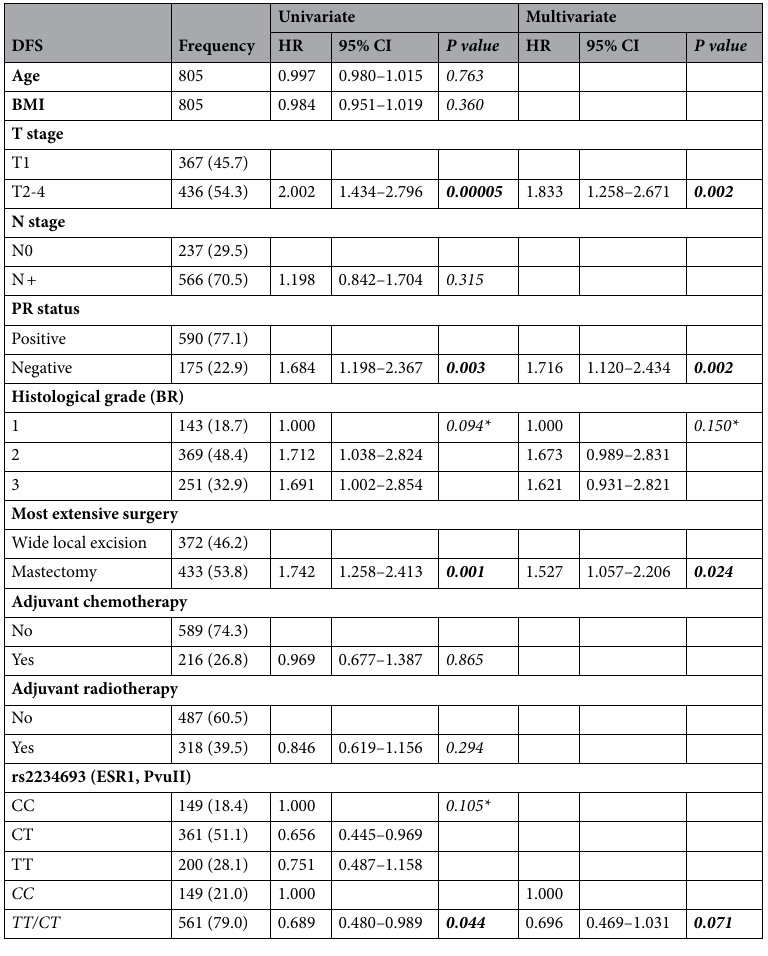
Table 2. Univariate and multivariate Cox models of DFS for different variables and rs2234693. DFS, disease free survival; HR, hazard ratio; CI, confidence interval; BMI, body mass index; PR, progesterone receptor; BR, Bloom Richardson. The multivariate analysis is compensated for T stage, PR status, histological grade, and type of surgery. Bold values indicate P < 0.05. *Global